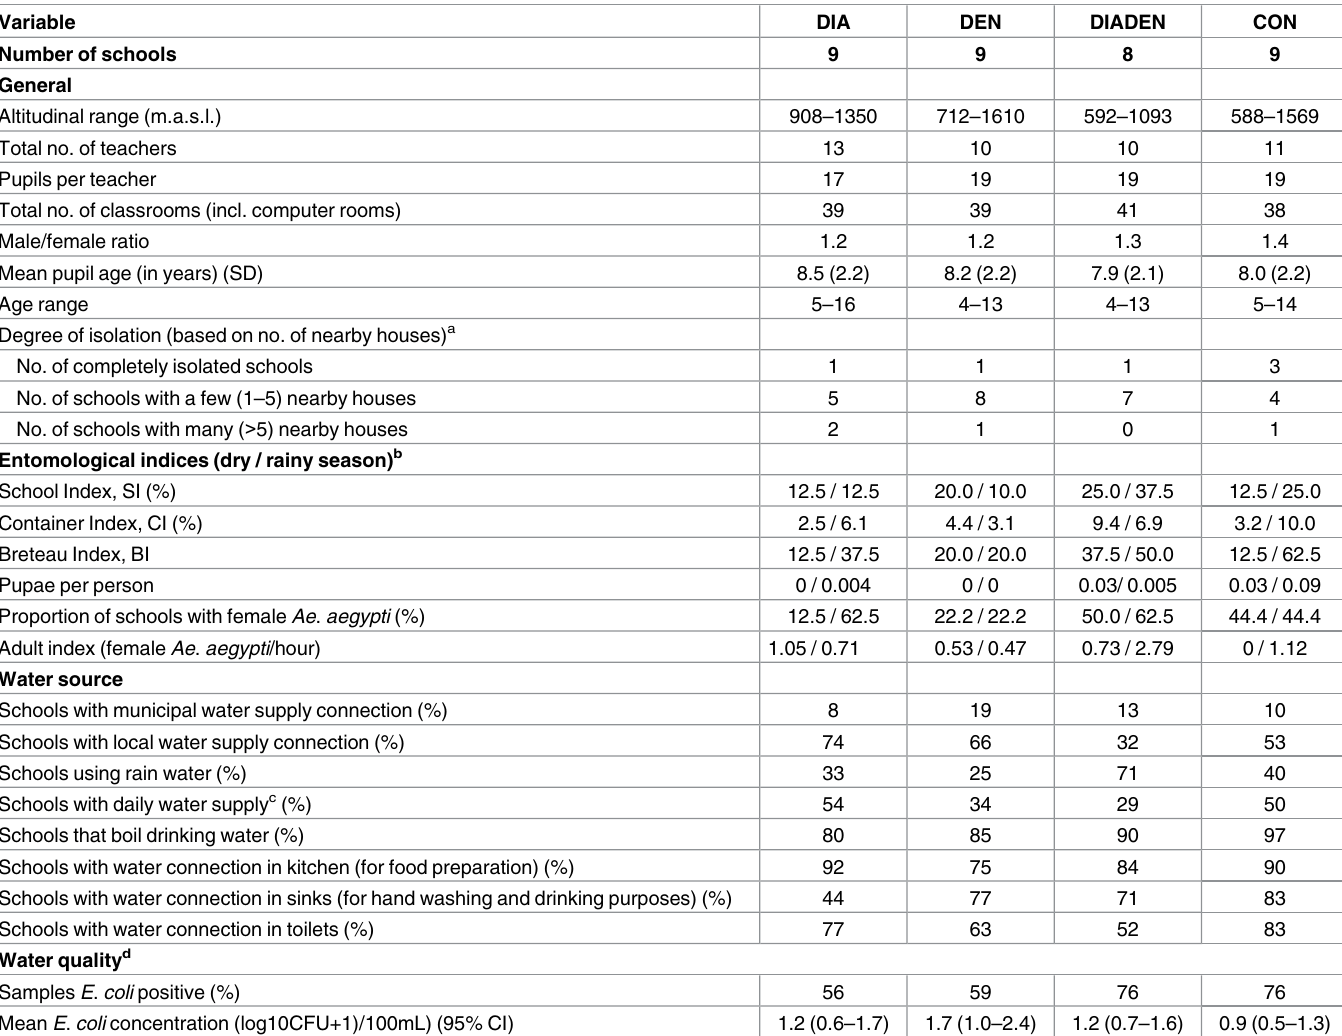
Table 1. Baseline characteristics of 35 rural primary schools allocated to four arms receiving either diarrhea (DIA), dengue (DEN), both (DIADEN), or no interventions (CON) in Anapoima and La Mesa municipalities, Colombia in 2011.